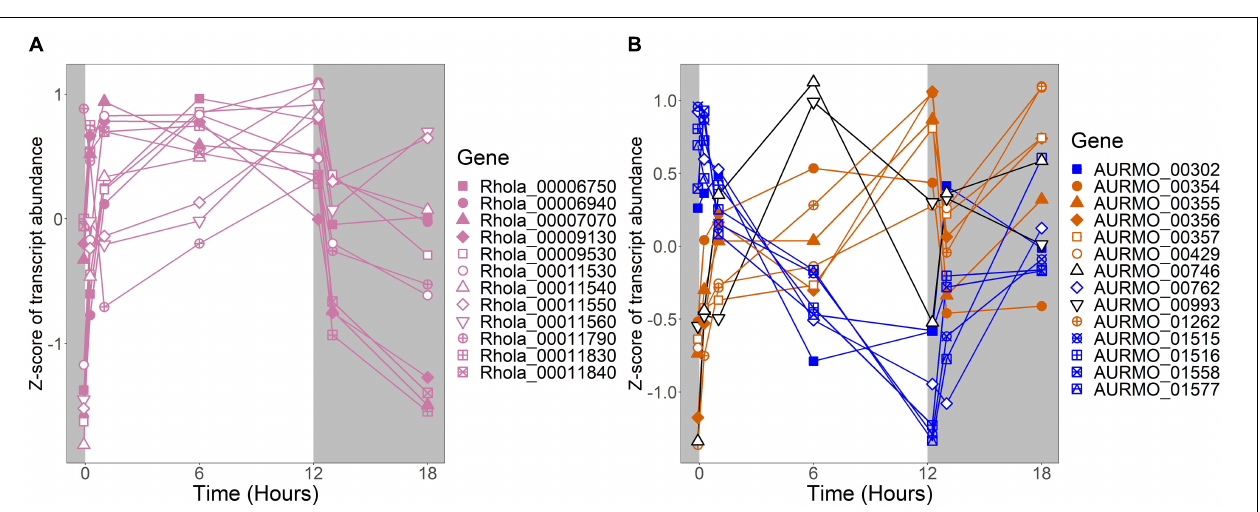
FIGURE 6 | Expression of putative TCA cycle genes. Putative competence genes were identified by blasting the amino acid sequences of known components of the E. coli TCA cycle against the genomes of R. lacicola and A. photophilum strain MWH-Mo1. Expression is plotted as z-score of each transcript. (A) Putative TCA cycle genes in R. lacicola have higher transcript levels in the light. (B) Putative TCA cycle genes in A. photophilum strain